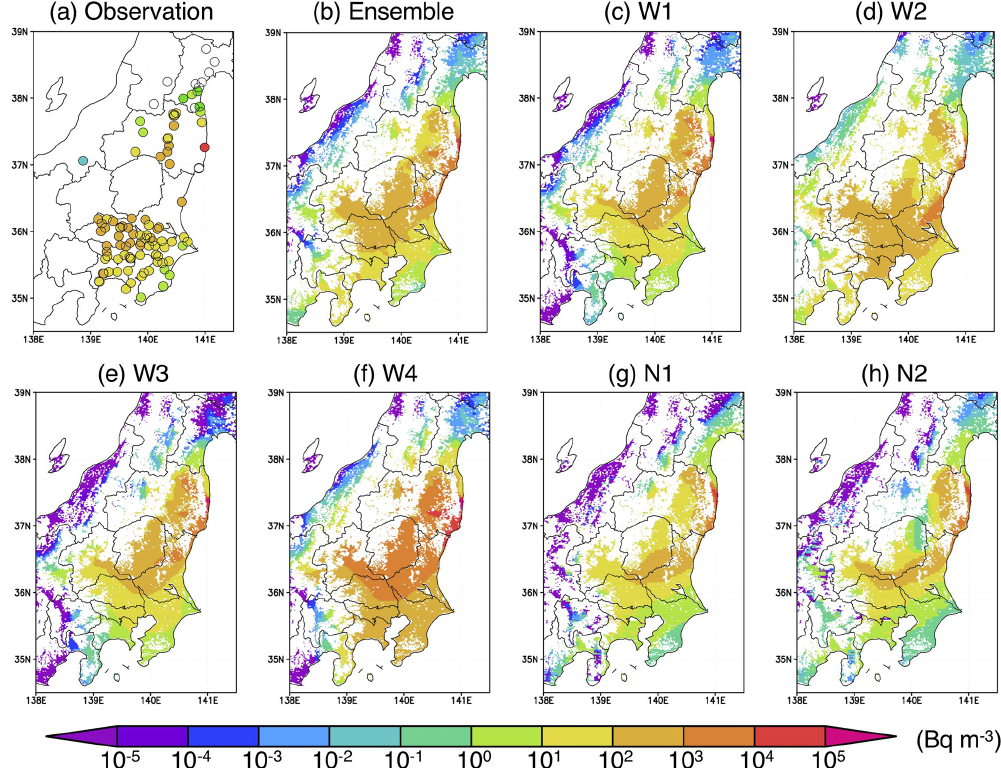
Figure 11. Spatial distribution of the (a) observed and (b–h) simulated daily integrated Cs-137 concentrations on 15 March 2011